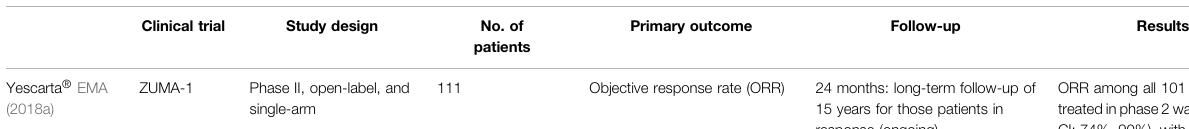
TABLE 2 | ( Continued ) Data from clinical trials for ATMPs approved in